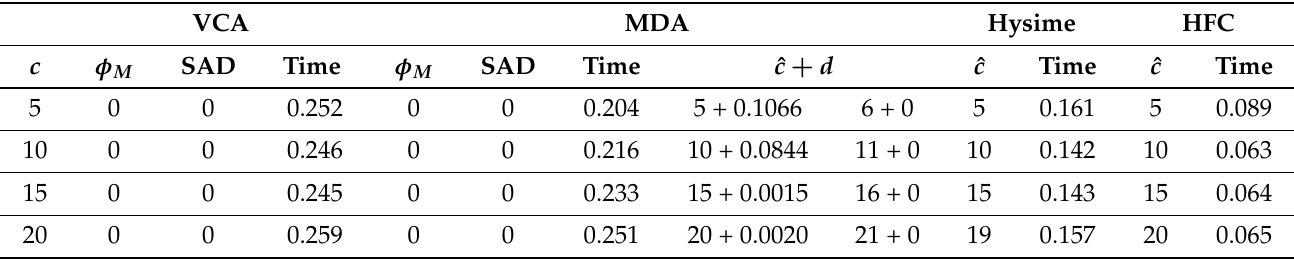
Table 1. Performance and processing time (seconds) for our proposed MDA algorithm on synthetic data containing pure mineral signatures and no noise under different number of endmembers. c and ˆ c are the actual and estimated number of endmembers, respectively. d denotes the maximum distance between all pixel points and the affine hull formed by all of the extracted